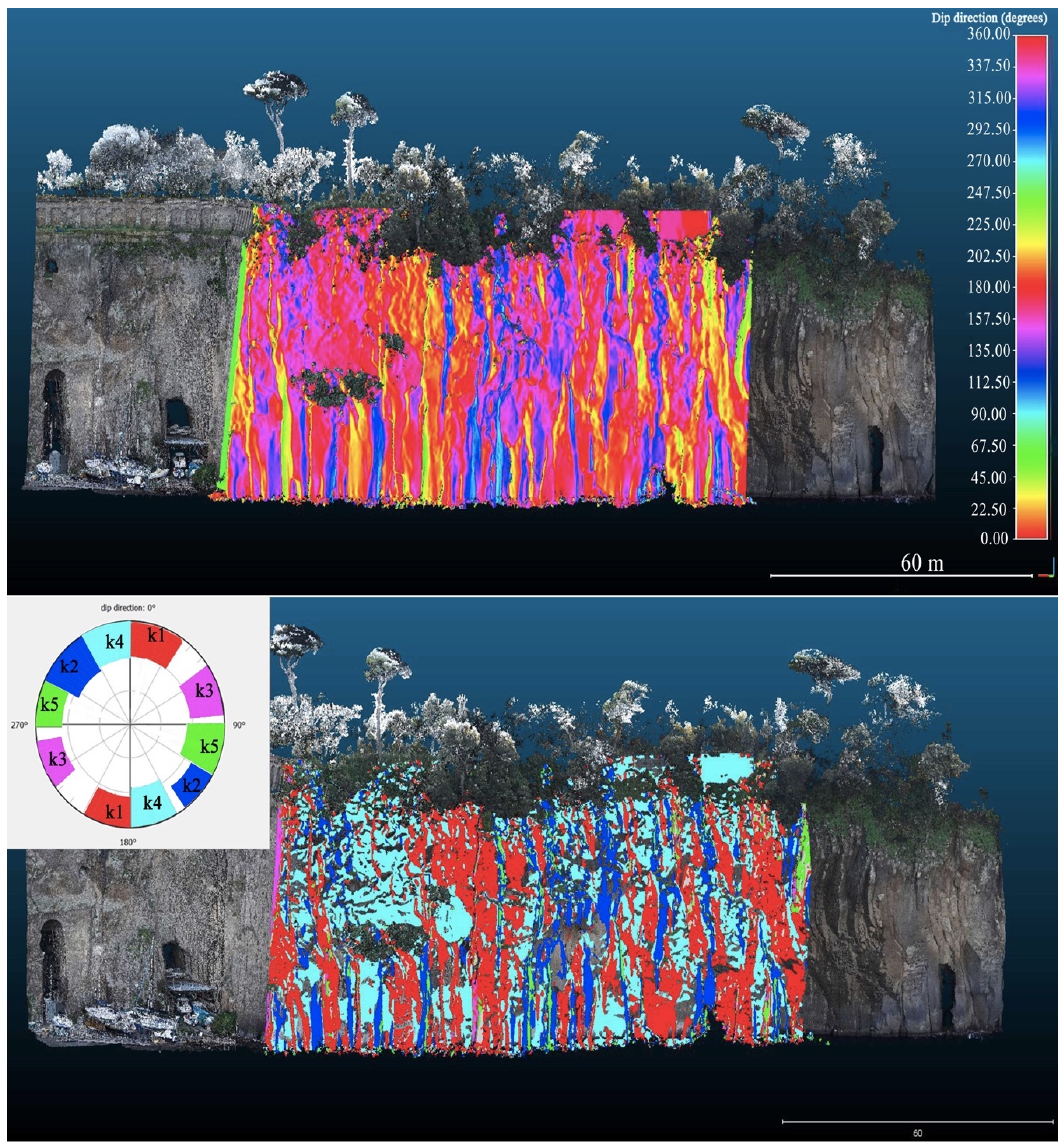
Figure 7. RGB point cloud at Santa Caterina rock cliff. Above: mapping the dip direction value attributed to the point cloud over the study area. Below: representation of the dip directions for each individual discontinuity set, distinguished by different colors; in the inset, the steroplot shows distribution of the sets.